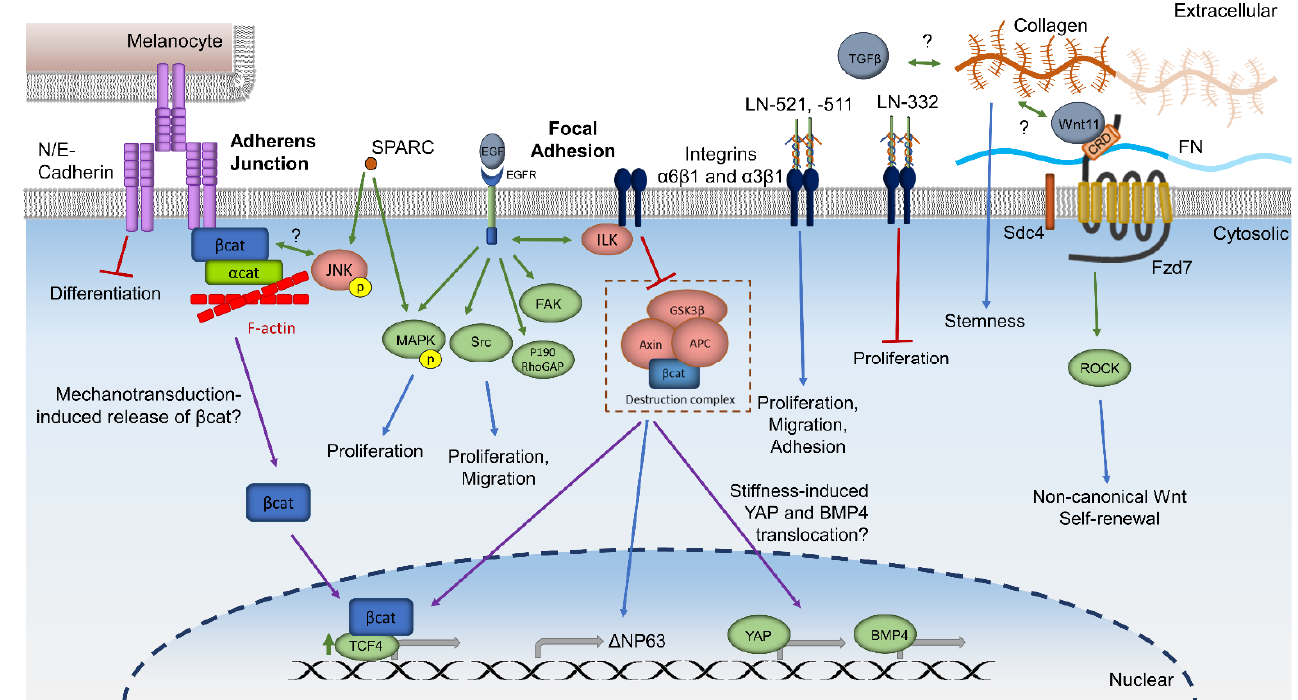
Figure 2. Summary and hypothesized mechanisms of ECM and membrane proteins involved in LSC regulation. LN: Laminin. FN: Fibronectin. Green arrows: activation. Red lines: inhibition. Blue arrows: downstream pathways or phenotype. Purple arrows: translocation. Gray arrows: gene expression. Double-sided arrows: crosstalk. ?: Hypothesized mechanisms based on experiments in non-corneal cells.